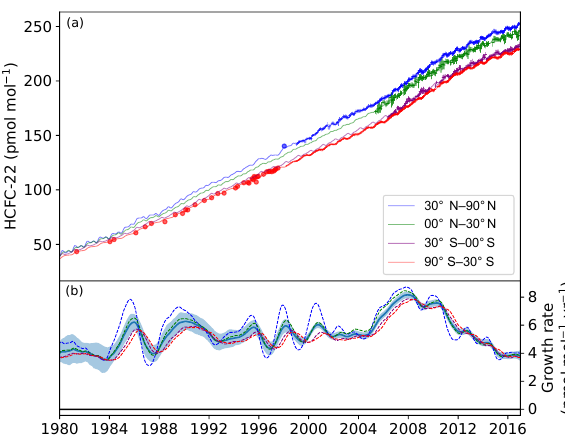
Figure 2. (a) HCFC-22 modelled mole fractions for the four equal- mass latitudinal subdivisions of the global atmosphere calculated from the 12-box model and the in situ records from the AGAGE core sites (points with error bars) and CGAA data (red circles, only shown for times without in situ data) and old NH air data (blue circles, only shown for times without NH in situ data). (b) shows the annual growth rates (global – blue solid line with uncertainty band; and individual semi-hemispheres – dashed lines) in pmolmol − 1 yr − 1 .